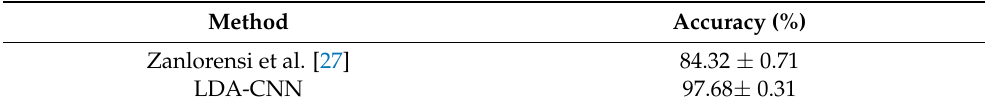
Table 8. Comparison of the performance of LDA-CNN model with existing method using UFPR